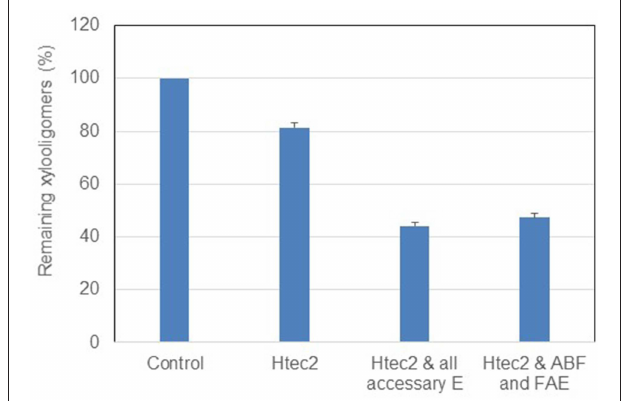
FIGURE 7 | Enzymatic degradation of xylooligomers in black liquor with supplement of accessary